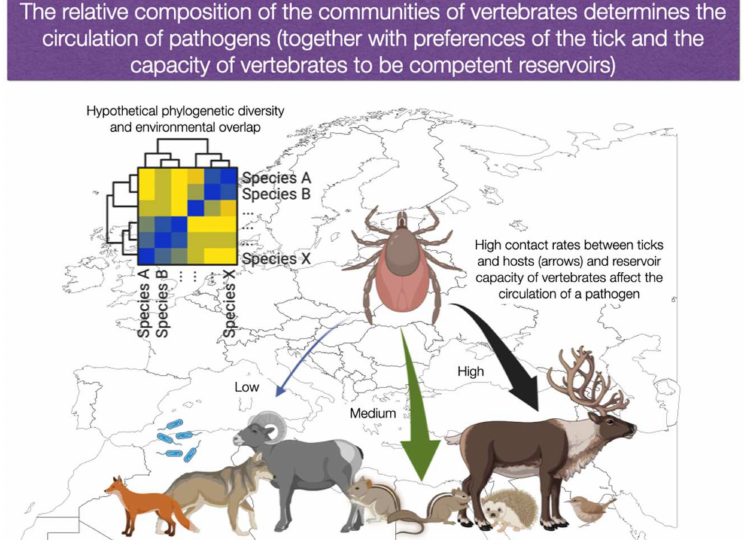
Figure 4. Wild vertebrates belong to communities of different relative composition according to the environmental features, such as climate or vegetation. Ticks have preferences for feeding on different species of vertebrates; in turn, vertebrates have different competence supporting the transmission of pathogens (reservoir capacity). The figure shows a hypothetical community of vertebrates that has a value of phylogenetic diversity and share portions of the habitat; only a few vertebrates hypothetically reservoir a pathogen (left). The transmission of TBP is, in part, due to the traits of each vertebrate and the contact rates of tick vectors with competent reservoirs. In the figure, arrows of different colours and sizes intend to illustrate hypothetical different contact rates among ticks and vertebrates. Thus, the species composition, the relative abundance of each vertebrate, the capacity to reservoir a pathogen, and the pressure of tick bites will shape the permanent circulation of pathogens. Parts of the illustration were created with BioRender.com (accessed on 1 November